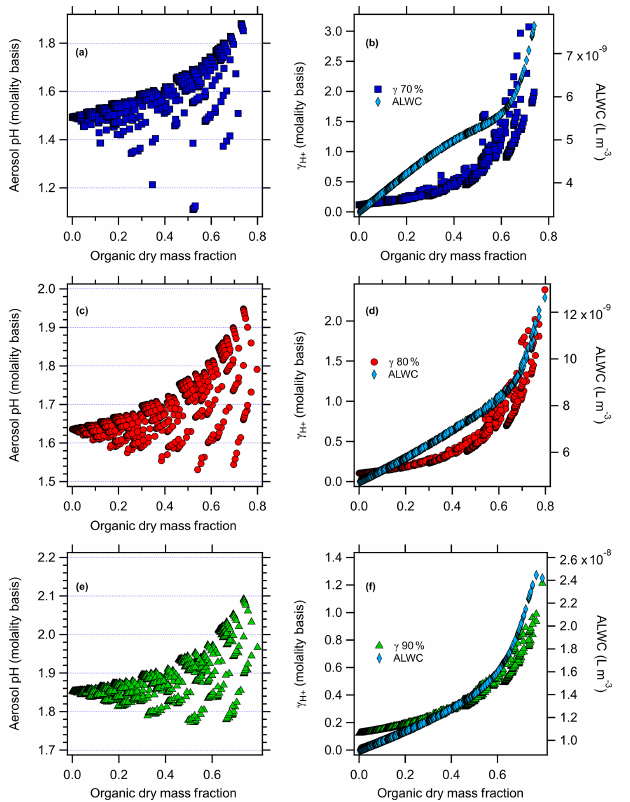
Figure 3. AIOMFAC-modeled aerosol pH (molality basis) versus organic dry mass fraction with the factorial addition of nonacid or- ganic species and AIOMFAC-modeled γ H + (molality basis) and aerosol liquid water (ALW, polynomial fit to AIOMFAC output) versus organic dry mass fraction (right panel) for Beijing at (a, b) 70% RH, (c, d) 80% RH, and (e, f) 90%